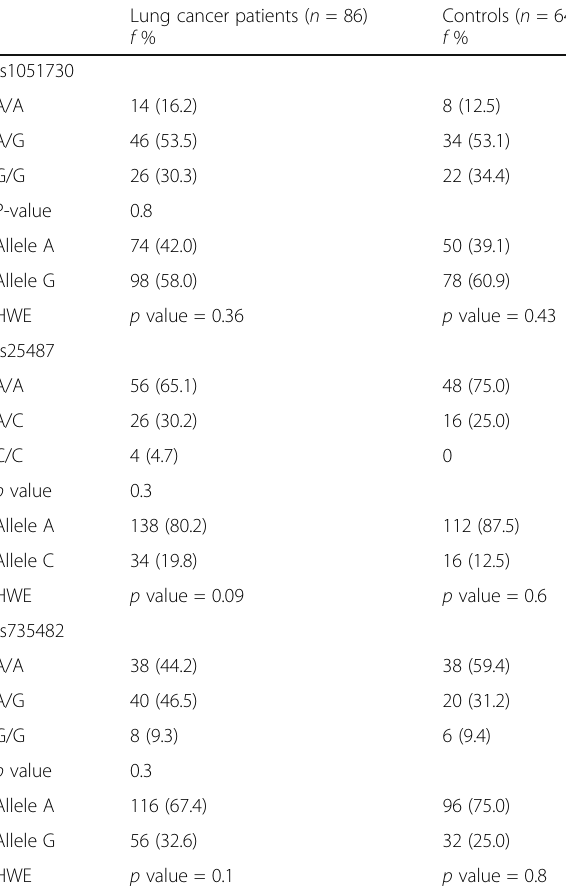
Table 2 Genotypes and alleles frequencies of the studied SNP in lung cancer patients and control